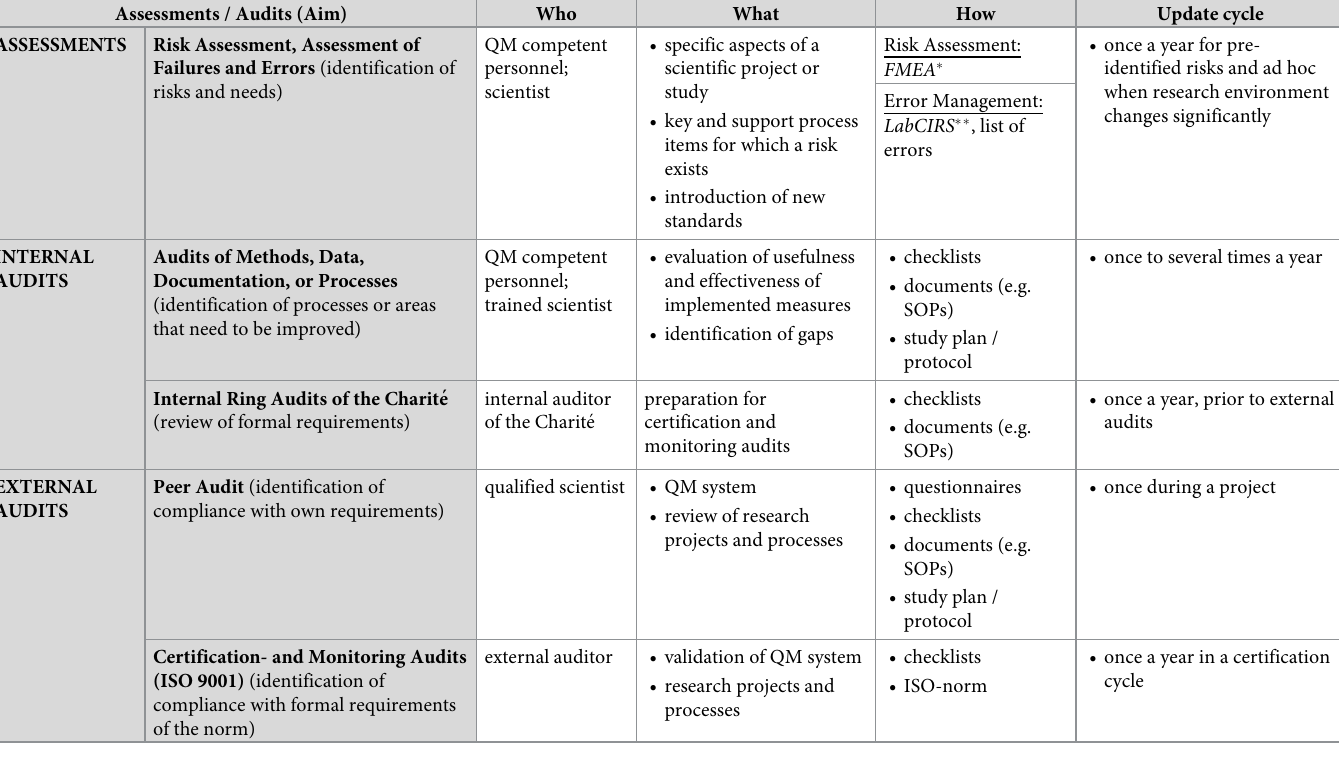
Table 1. Types of audits and assessments performed at the Department of Experimental Neurology. For a more detailed description of specific assessments and audits, see Table 2. Assessments / Audits